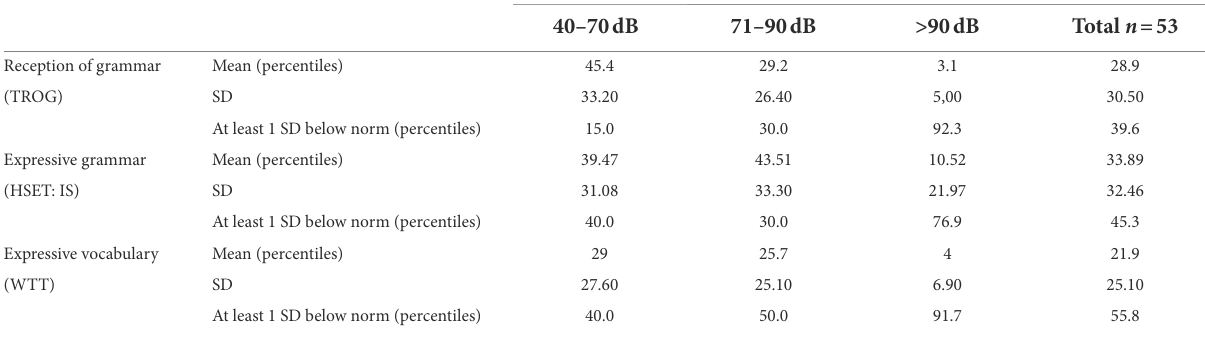
TABLE 3 Language results by degree of hearing loss (means and standard deviations in percentiles and percentage below 1